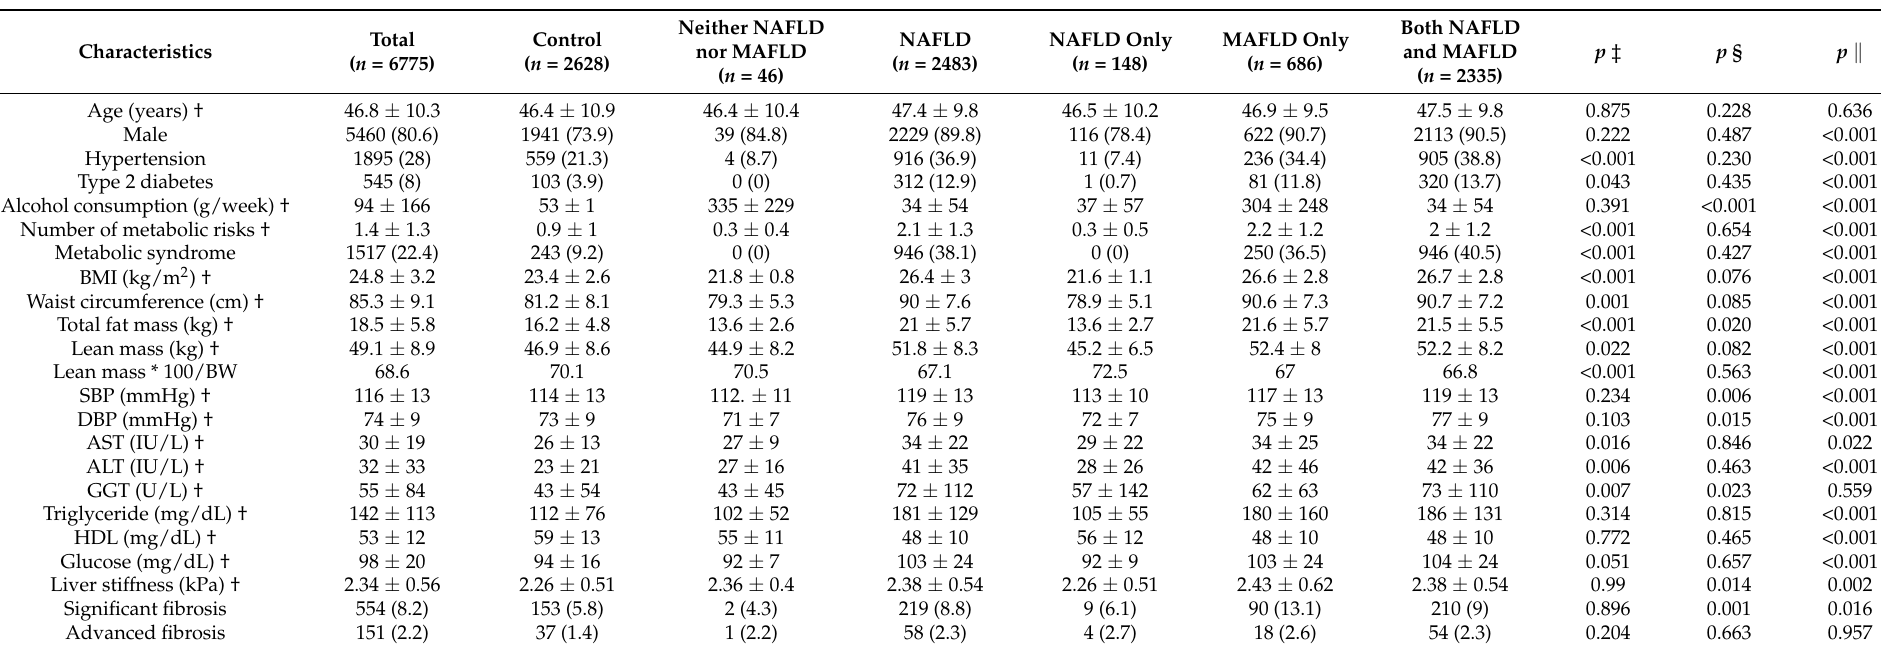
Table 1. Baseline characteristics of patients who underwent MRE and abdominal ultrasound during health check-ups, according to the definitions of NAFLD and MAFLD.